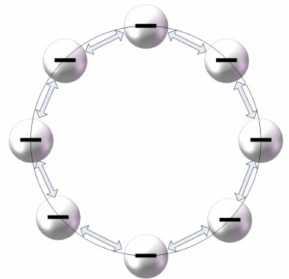
Figure 5. Diagram of force acting on charged jets at annular tip.